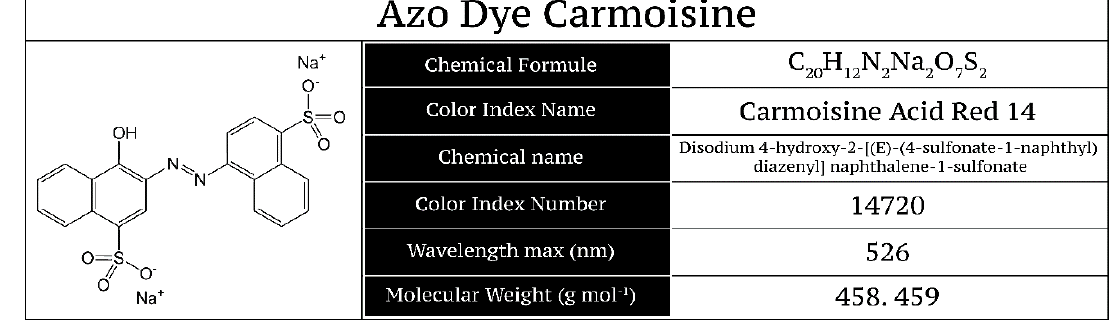
Figure 1. Chemical structure of azo dye Carmoisine (Acid Red 14 or additive E122).